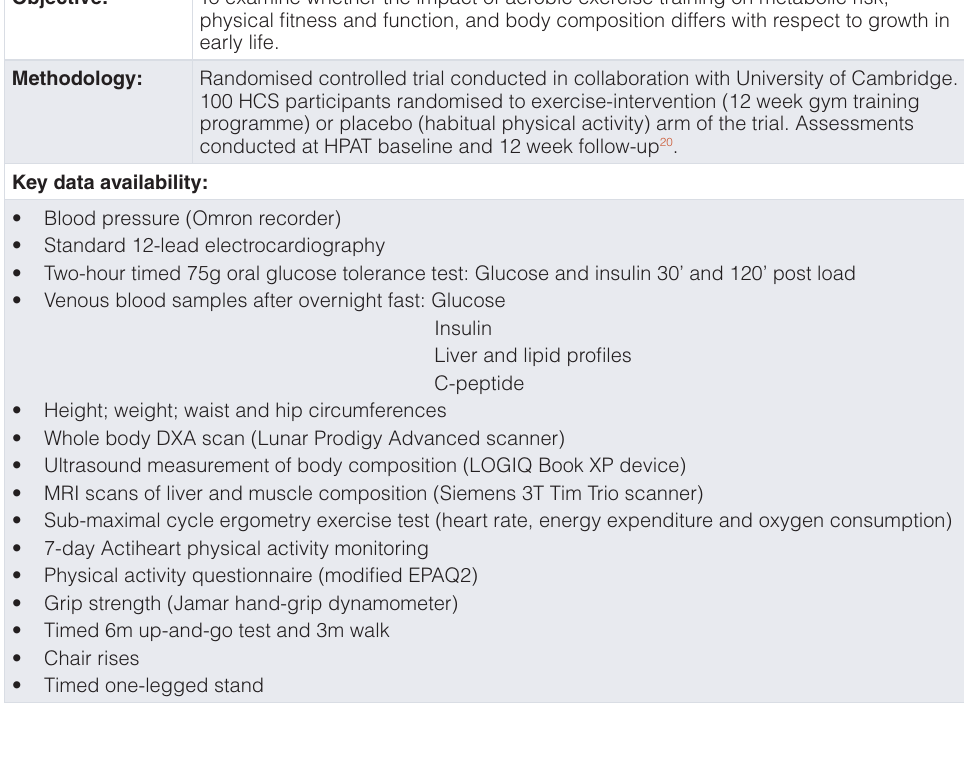
Table 5. Hertfordshire Physical Activity Trial (HPAT). Objective: early life.